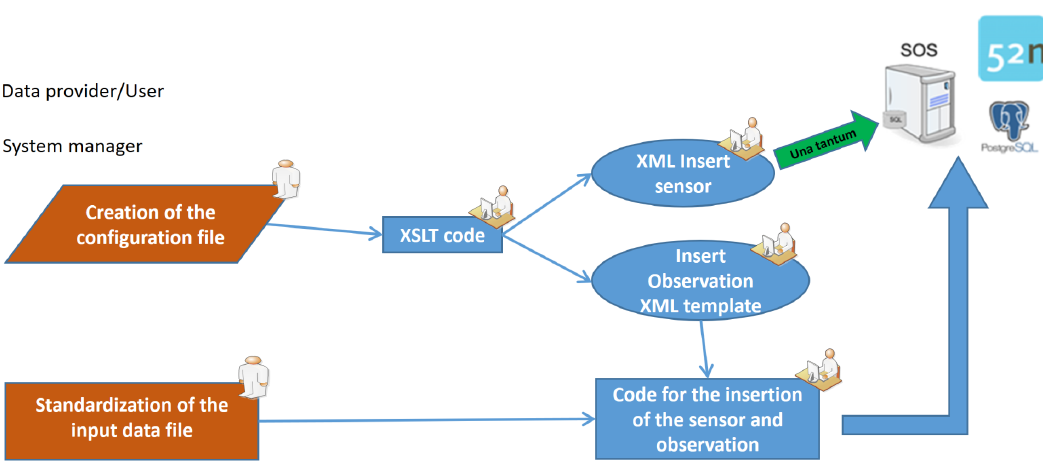
Figure 4. Schema for the insertion of the sensors and observations. From the data provider/user point of view, only two actions are requested (in orange): Create a configuration file and standardize the input data